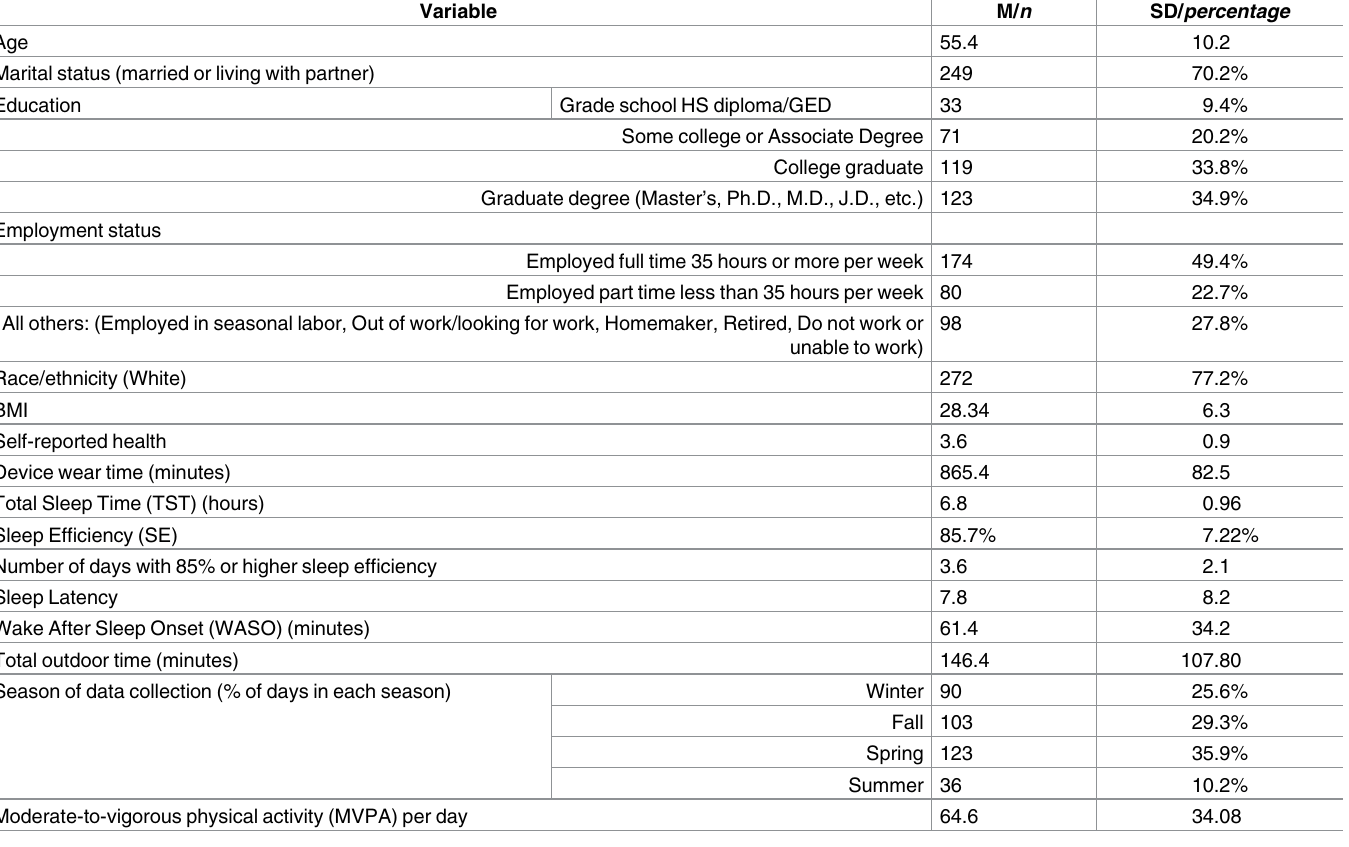
Table 1. Demographic, physical activity, and sleep characteristics of the adult female convenience sample (N = 352).